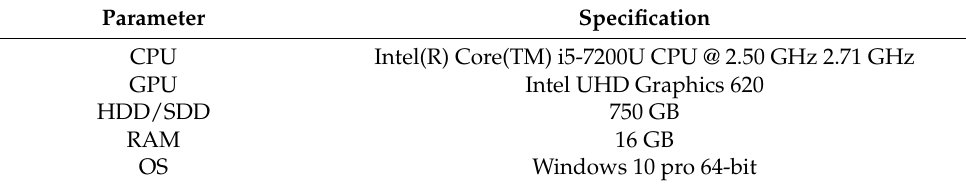
Table 3. Machine